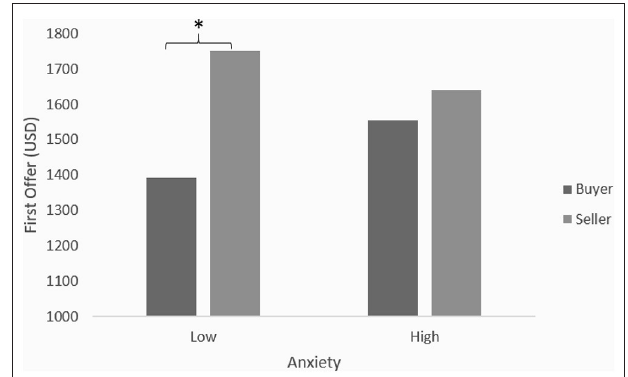
FIGURE 1 | Mean first offer—ford thunderbird negotiation. * p <